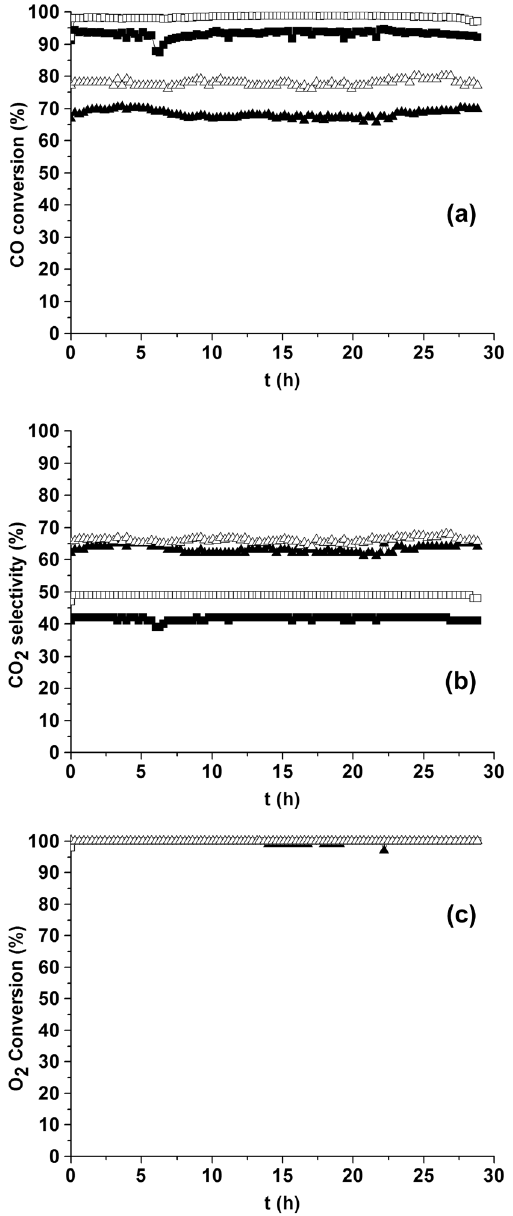
Fig. 5 Long-term tests of Pt/CeO 2 catalysts at 50 °C: ( a ) CO conver- sion, ( b ) CO 2 selectivity, and ( c ) O 2 conversion (filled square Pt1/ CeO 2 1% O 2 , filled triangle Pt1/CeO 2 0.5% O 2 , empty square Pt0.5/ CeO 2 1% O 2 , and empty triangle Pt0.5/CeO 2 0.5% O 2